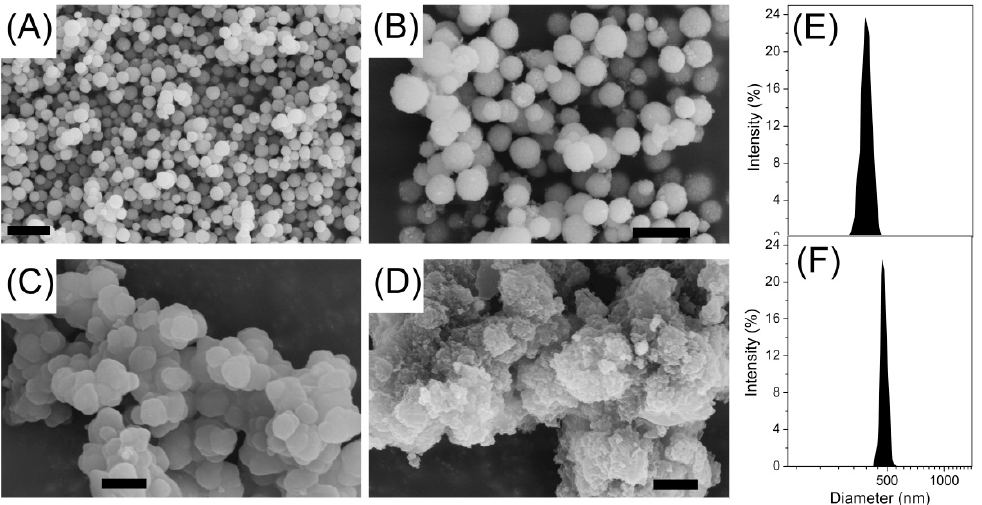
Figure 3. The typical scanning electron microscopy (SEM) photographs of the as-prepared particles: Fe 3 O 4 ( A ); Fe 3 O 4 @SiO 2 ( B ); Fe 3 O 4 @MIPs ( C ) and Fe 3 O 4 @NIPs ( D ); size distribution of the Fe 3 O 4 ( E ); and Fe 3 O 4 @SiO 2 ( F ). The scale bars all represent 1 µm.